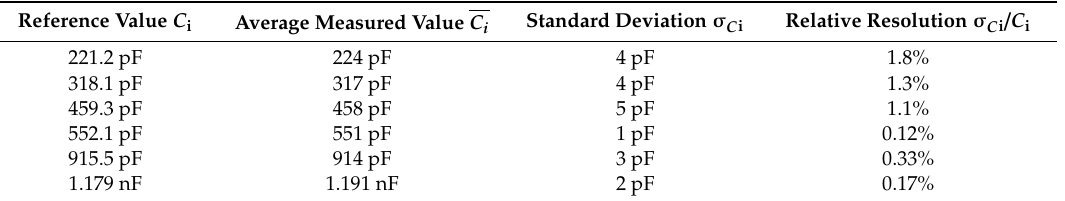
Table 2. Reference values C i , average values C i , standard deviations σ Ci and relative resolution σ C i / C i estimated over N = 40 repeated measurements obtained with the system prototype.